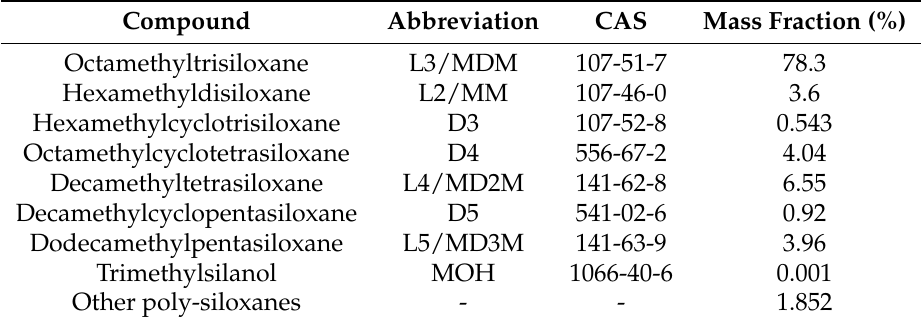
Table 5. HS-GC-MS analysis results of cycle fluid (source: feed pump)